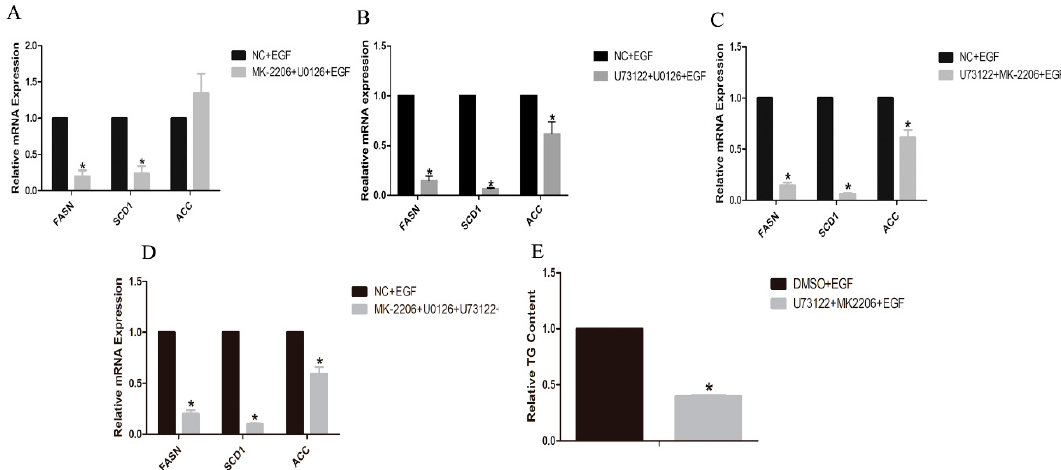
Figure 7. E ff ects of the combination of two or more inhibitors on the expressions of genes involved in lipid metabolism in GMECs. ( A ) GMECs were treated with 500 nM MK-2206 (Akt inhibitor), 10 µ M U0126 (MEK inhibitor) and 50 ng / mL EGF for 24 h, to investigate the mRNA levels of genes involved in lipid metabolism in GMECs. ( B ) GMECs were treated with 20 µ M U73122 (PLC- γ 1 inhibitor), 10 µ M U0126 (MEK inhibitor) and 50 ng / mL EGF for 24 h, to investigate the mRNA levels of genes involved in lipid metabolism in GMECs. ( C ) GMECs were treated with 20 µ M U73122 (PLC- γ 1 inhibitor), 500 nM MK-2206 (Akt inhibitor) and 50 ng / mL EGF for 24 h, to investigate the mRNA levels of genes involved in lipid metabolism in GMECs. ( D ) GMECs were treated with 20 µ M U73122 (PLC- γ 1 inhibitor), 500 nM MK-2206 (Akt inhibitor), 10 µ M U0126 (MEK inhibitor) and 50 ng / mL EGF for 24 h, to investigate the mRNA levels of genes involved in lipid metabolism in GMECs. ( E ) GMECs were treated with 20 µ M U73122, 500 nM MK-2206 and 50 ng / mL EGF for 24 h, to investigate TG content in GMECs. Values are presented as mean ± SD of three independent experiments. * Means p < 0.05.